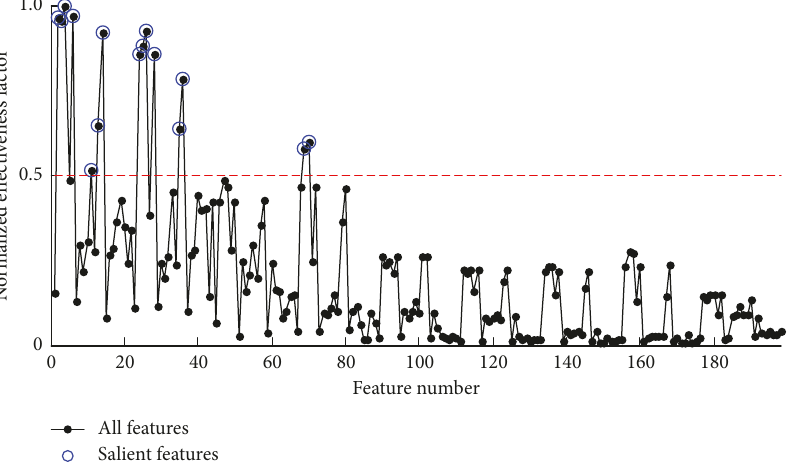
Figure 16: Salient features when EMD is applied in experiment 1. Table 5: Classification accuracy of MMC-CH ( n � 1 , 2 ,...,N ) in experiment 1.